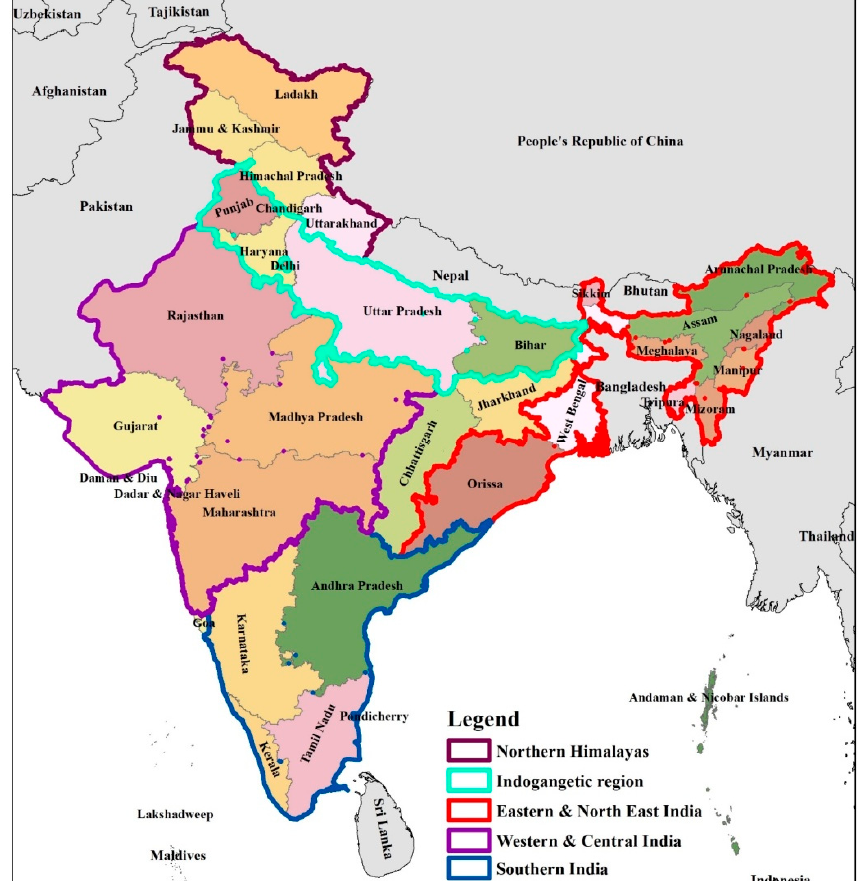
Figure 1. Grouping of Indian states for evaluation of AFS carbon storage potential.